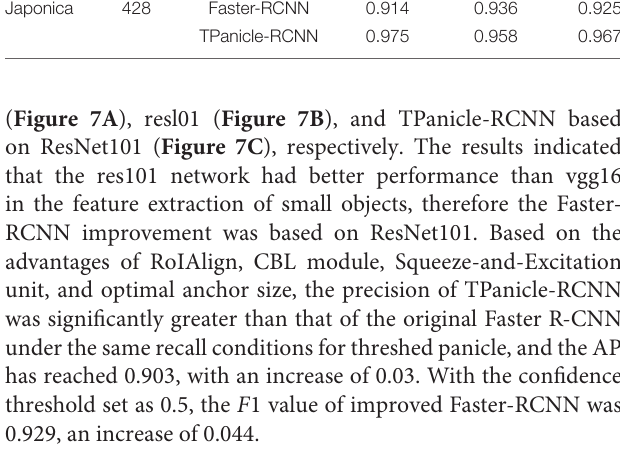
Frontiers in Plant Science |